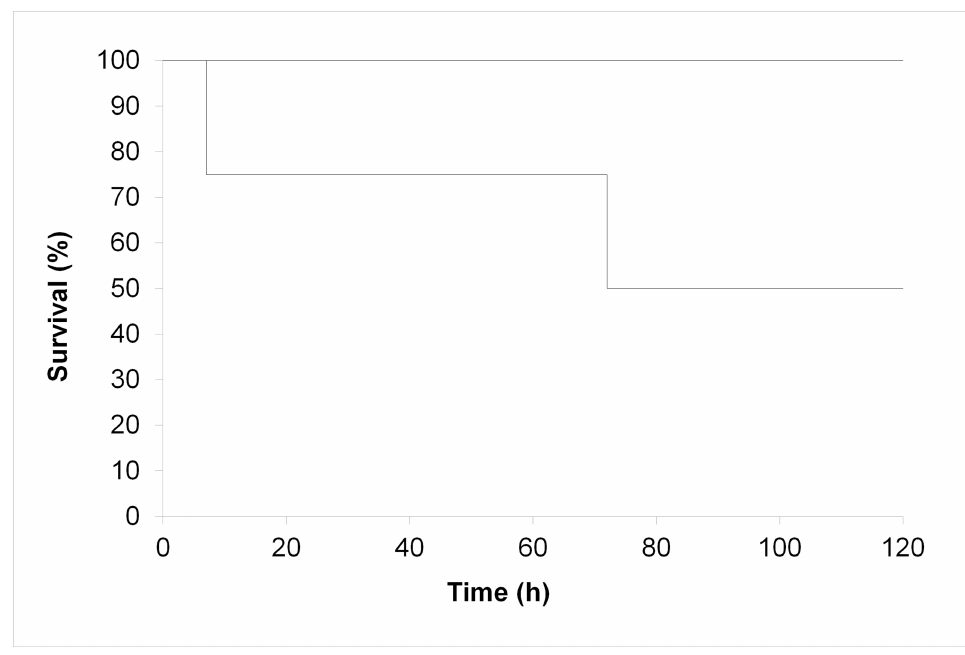
Fig 2. Animal survival and graft survival. Animal survival and graft survival censoredfor death with functioning